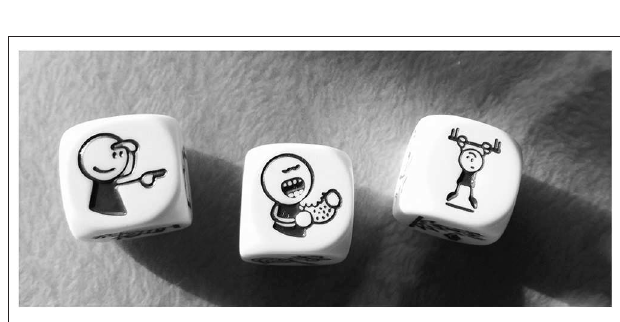
FIGURE 3 | Example of thrown